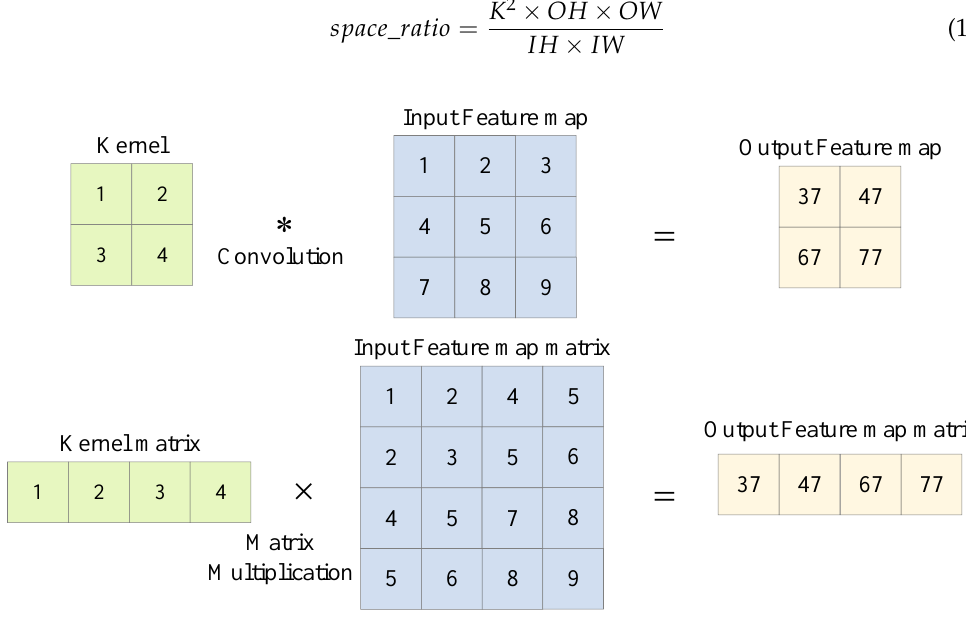
Figure 11. Two-dimensional convolution with kernel size 2 ×